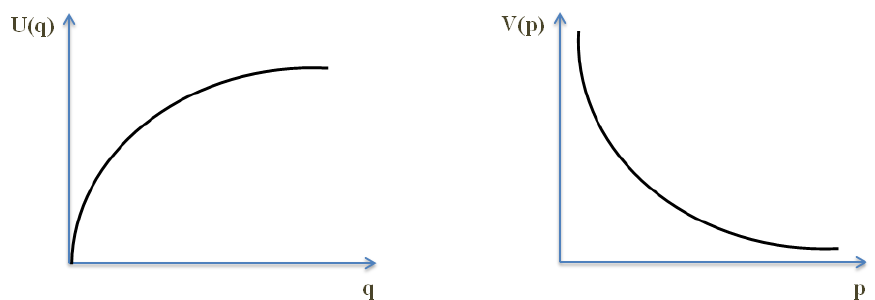
Figure 3. Direct utility function (DUF) versus indirect utility function (IUF). Source: Author’s own drawing